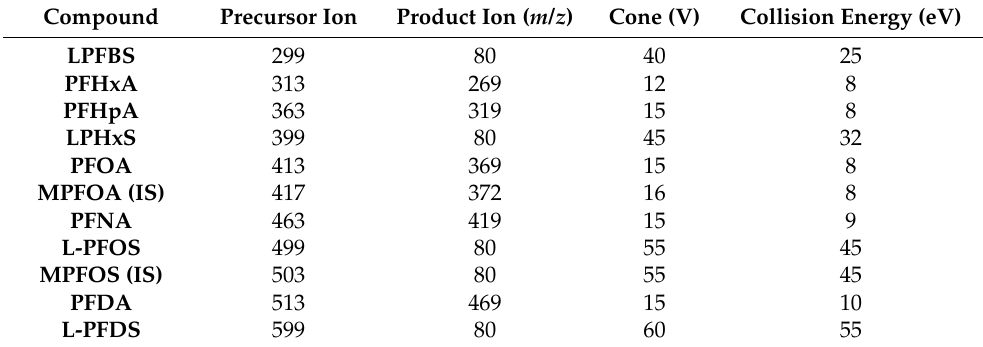
Table 1. Mass transitions and compound-specific